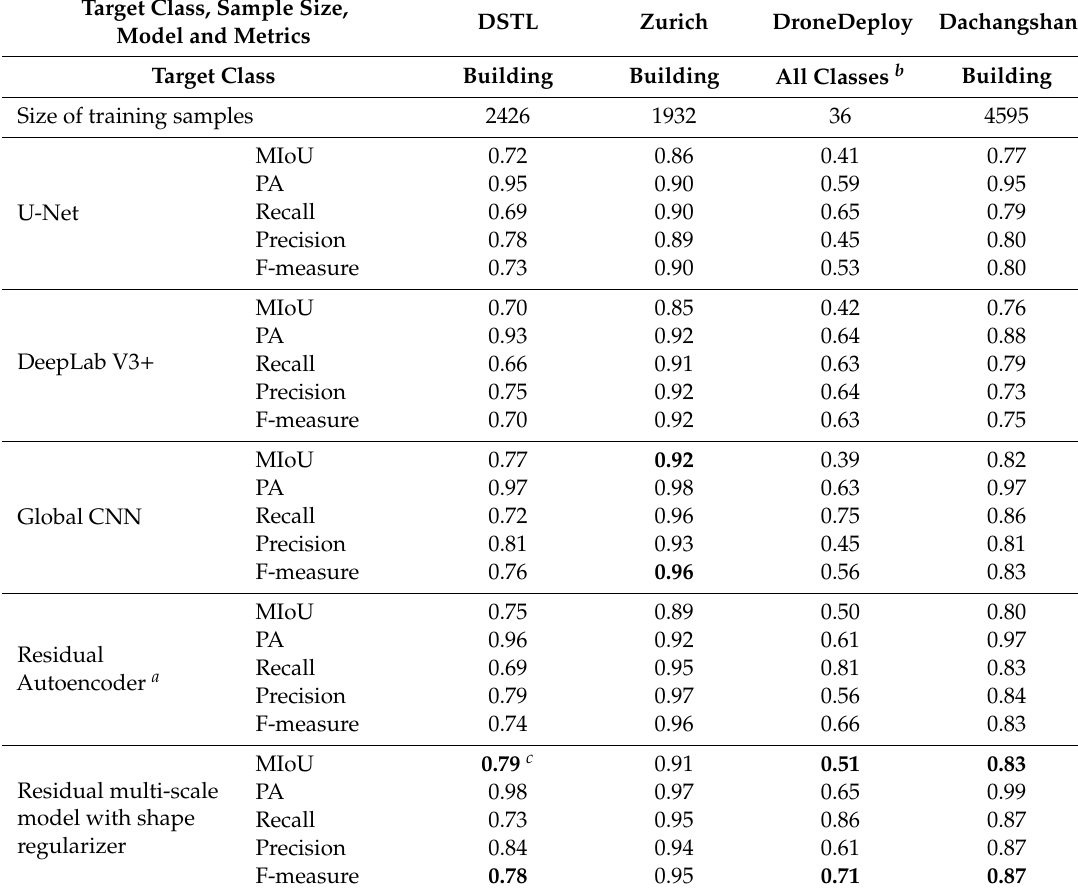
Table 2. Comparison of the results of the independent tests on four datasets (DSTL, Zurich, DroneDeploy and Dachangshan) and five